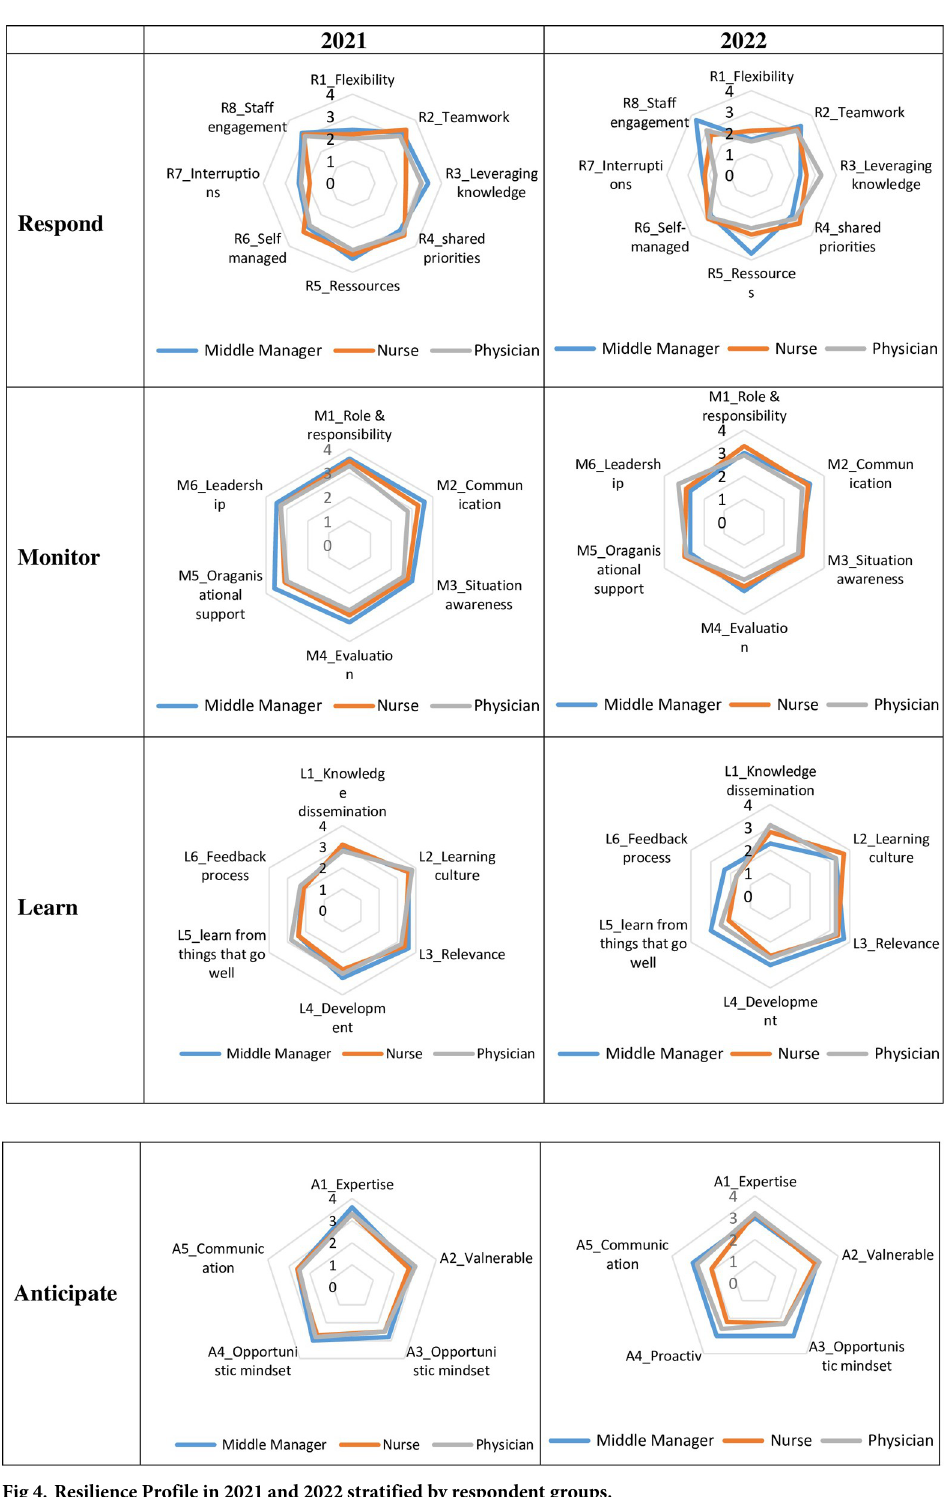
Fig 4. Resilience Profile in 2021 and 2022 stratified by respondent groups.